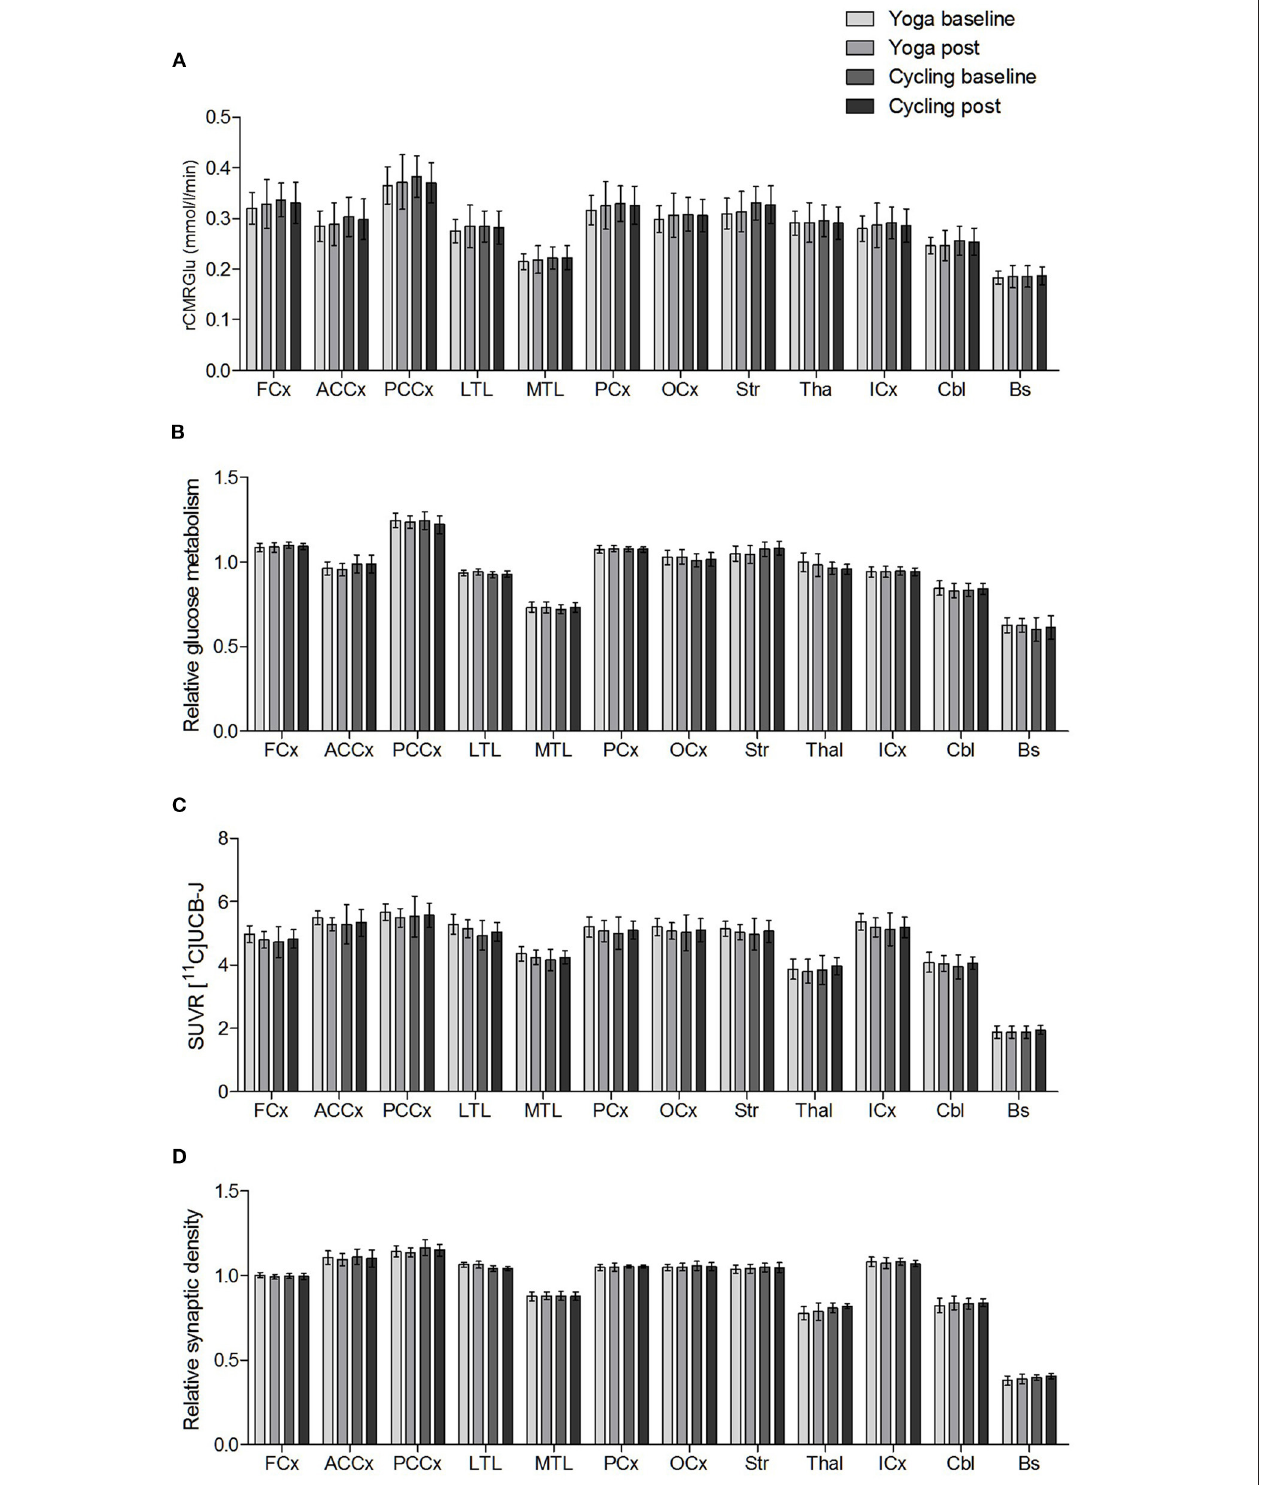
FIGURE 2 | Regional mean (A) absolute glucose metabolism (rCMRGlu), (B) relative glucose metabolism, (C) SUVR [ 11 C]UCB-J, and (D) relative synaptic density in the composite VOIs (FCx, frontal cortex; ACCx, anterior cingulate cortex; PCCx, posterior cingulate cortex; LTL, lateral temporal lobe; MTL, medial temporal lobe; PCx, parietal cortex; OCx, occipital cortex; Str, striatum; Thal, thalamus; ICx, insular cortex; Cbl, cerebellum; Bs, brainstem). Error bars represent one standard deviation.